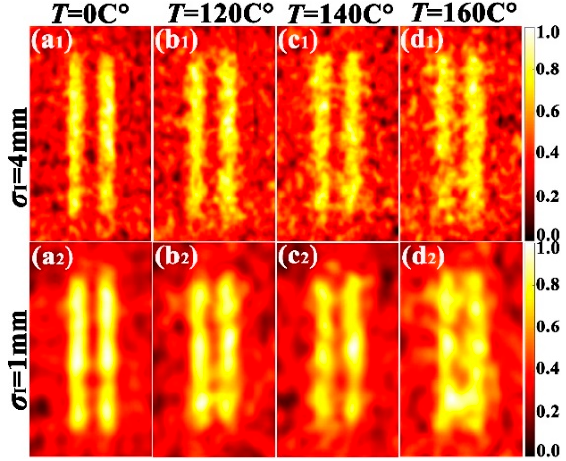
Figure 8. Normalized lensless ghost image with initial beam width σ I = 4 mm (first row) and σ I = 1 mm (second row) at several different temperatures of the hot plate. The distance between the two paths is l = 0.23